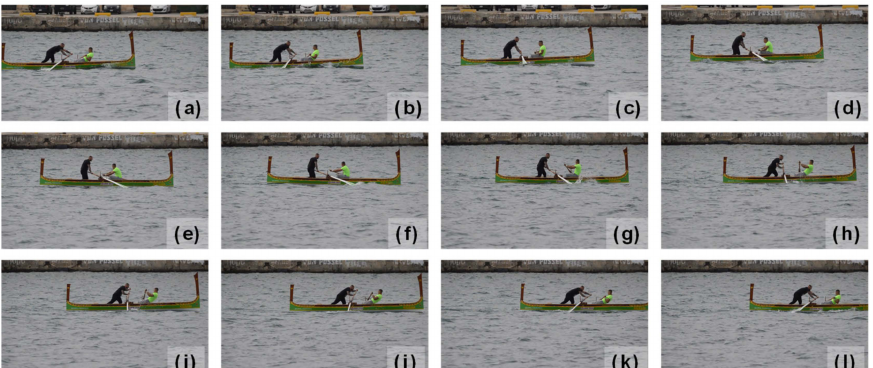
Figure 3. A detailed sequence of images showing the kinematics of standing rowing recorded on water on a Maltese Dg ¯ hajsa tal-Pass . Note that the catch, drive, finish and recovery of the sitting and standing rowers is synchronised, as is normal in rowing. ( a – l ) illustrate different parts of the stroke with ( a , l ) representing the finish; with the catch commencing at ( e ).